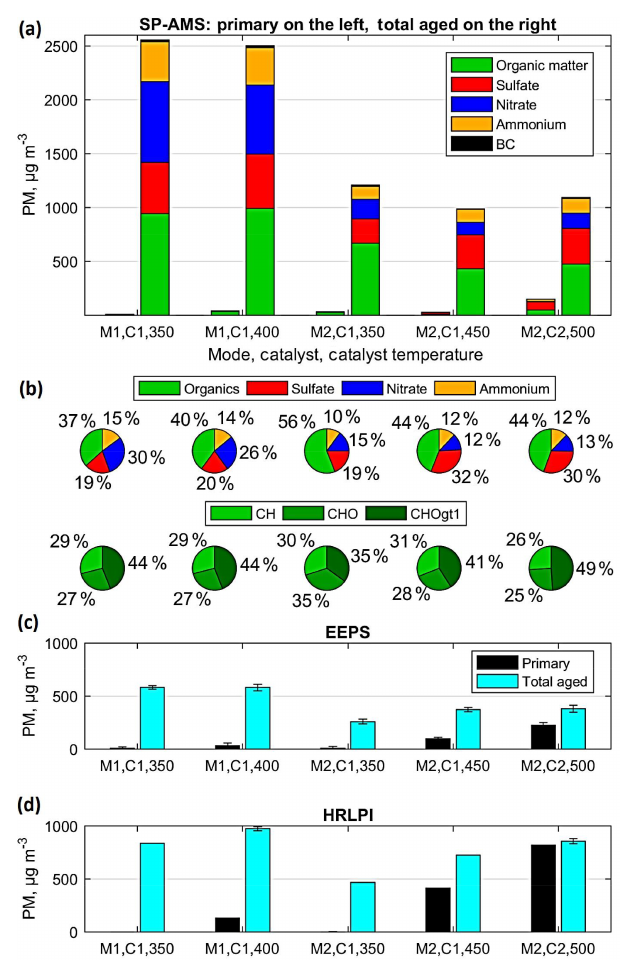
Figure 2. Exhaust primary and total aged particle mass concentra- tions measured by (a) SP-AMS, (c) EEPS and (d) HRLPI at differ- ent engine modes and catalyst temperatures. All values have been corrected by dilution ratio used in the sampling system. Secondary particle mass can be calculated by subtracting primary from total aged emission. The composition of the total aged particulate matter and the organic particulate matter is presented as pie charts (b) . The fraction of black carbon is less than or equal to 1% and therefore left out from the pie